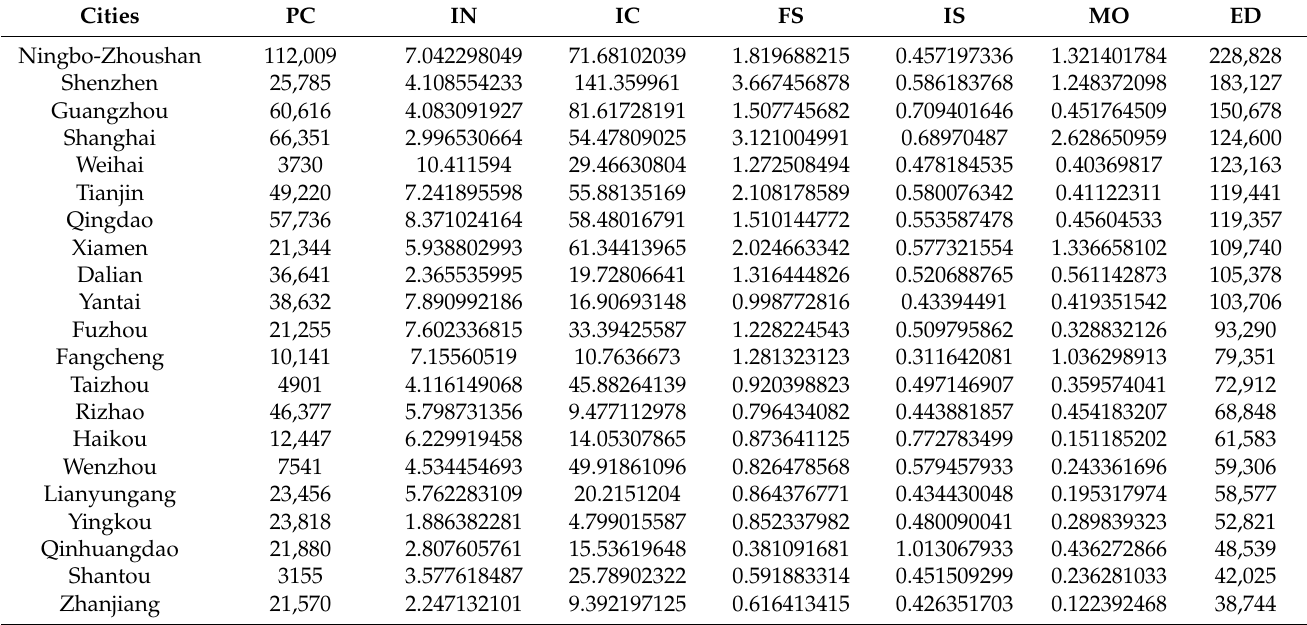
Table 2. Initial data used for calibration.